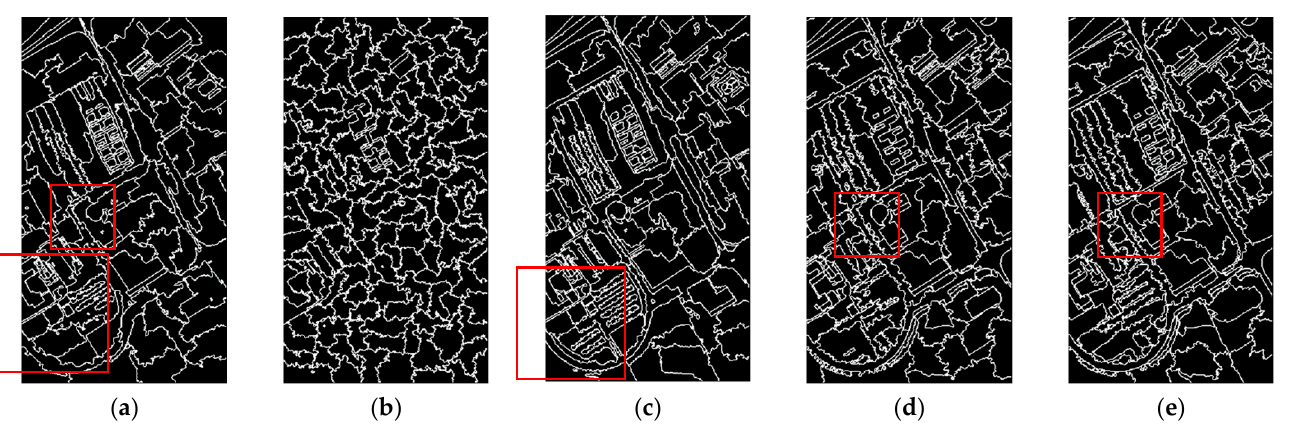
Figure 7. The segmentation results of ERS on different bands of PU: ( a ) the first principal compo-